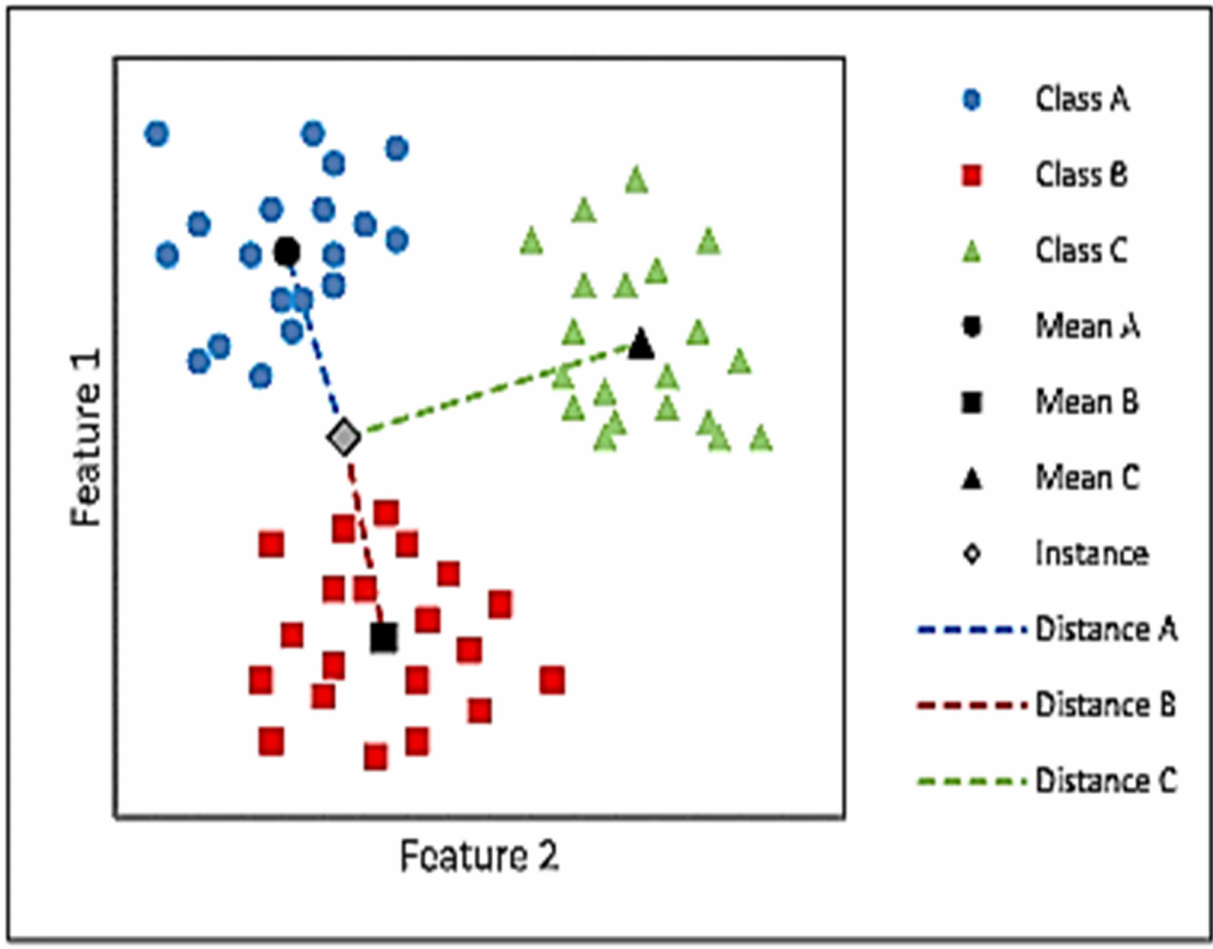
Figure 6. Classification with